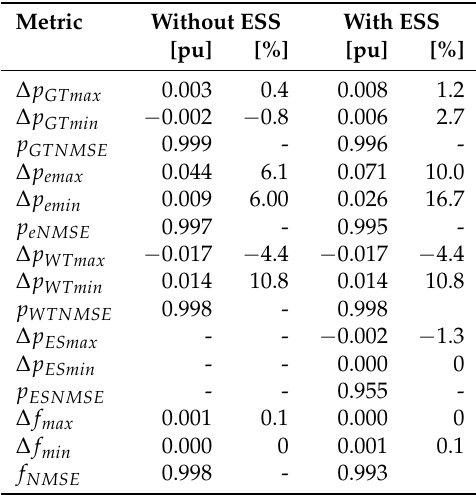
Table 2. Metrics comparing the detailed and simplified models. Metric Without ESS With ESS [pu]